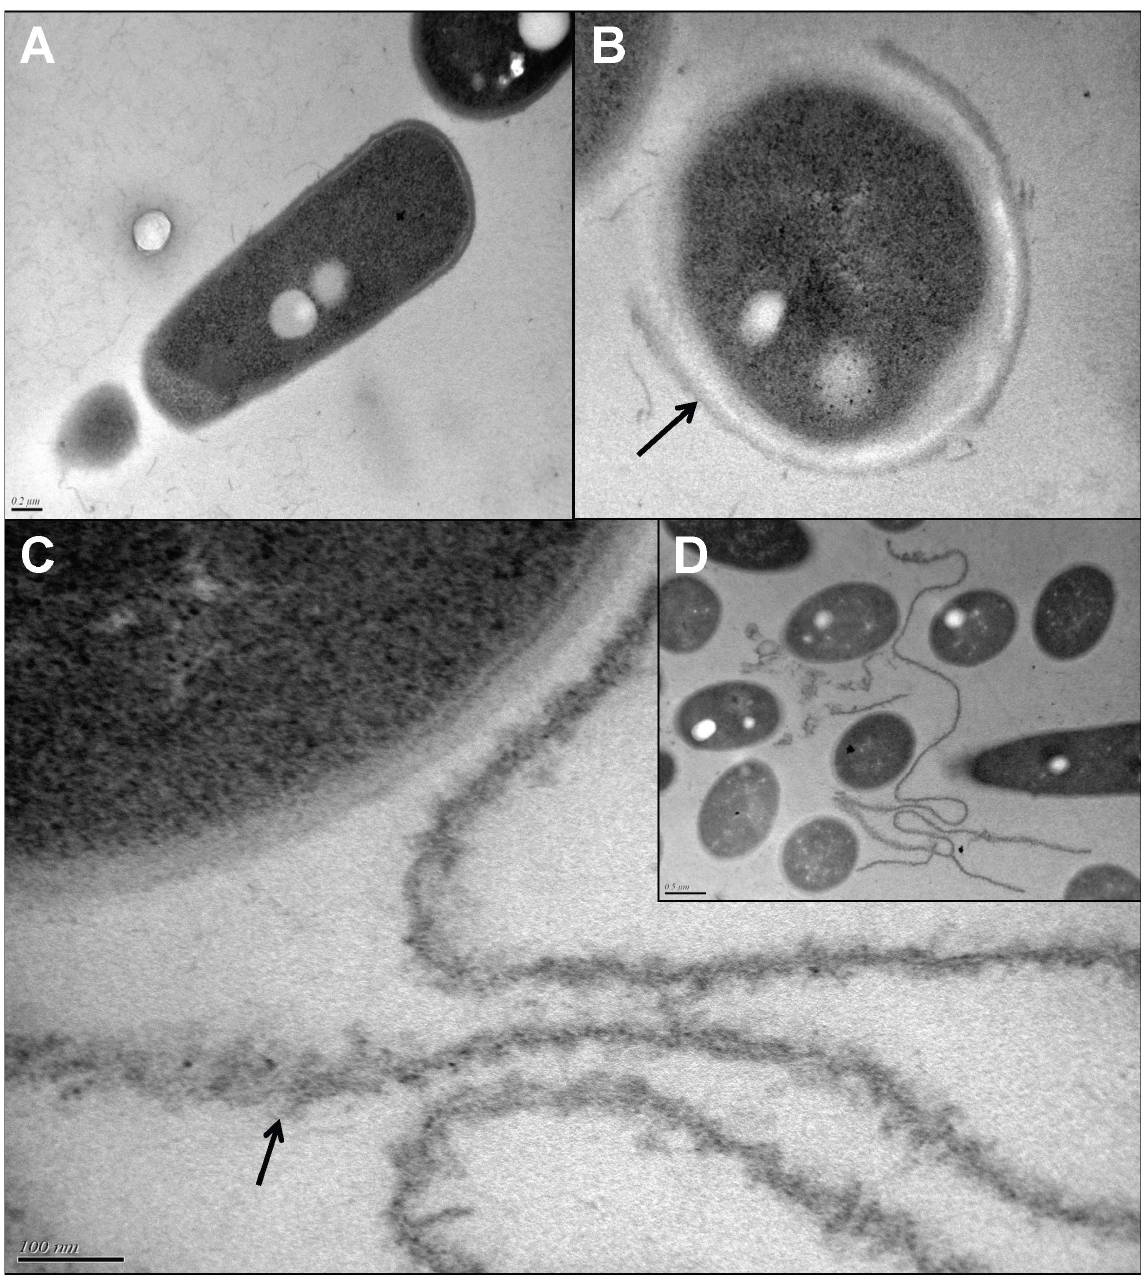
Figure 5. TEM observation of control (SPrev) and Substance P (SP) treated Bacilluscereus . Whereas control bacteria presented a continuous intact surface ( A ), bacteria exposed to SP showed a detachment of the S-layer ( R ) ( B ). Long amorphous structures were observed in the vicinity of bacterial, suggesting a desquamation of the S-layer ( C, D ).